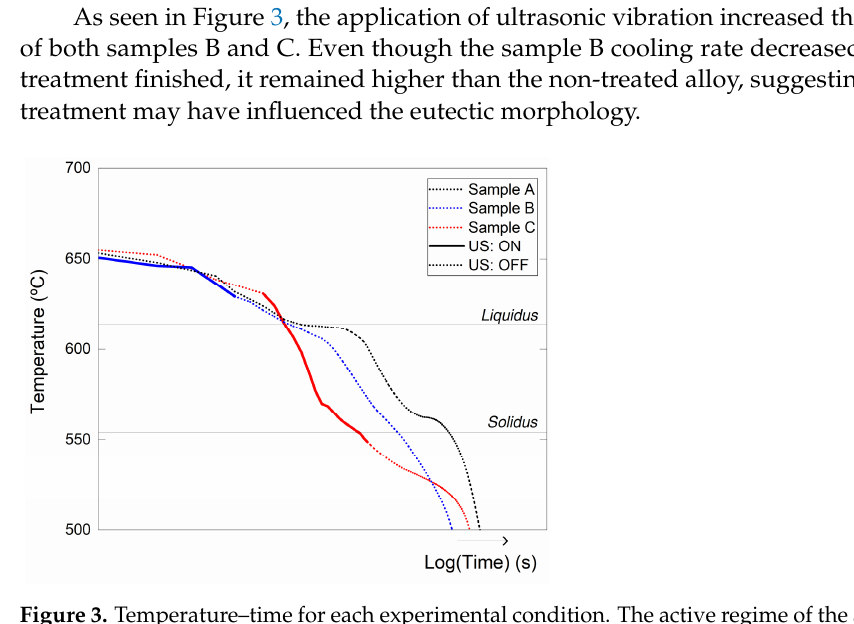
Figure 2. As ‐ cast optical and polarized micrographs of ( a ) sample A—no treatment; ( b ) sample B— US treatment fully above liquidus; and ( c ) sample C—US treatment from liquidus to solidus (magnification ×10).